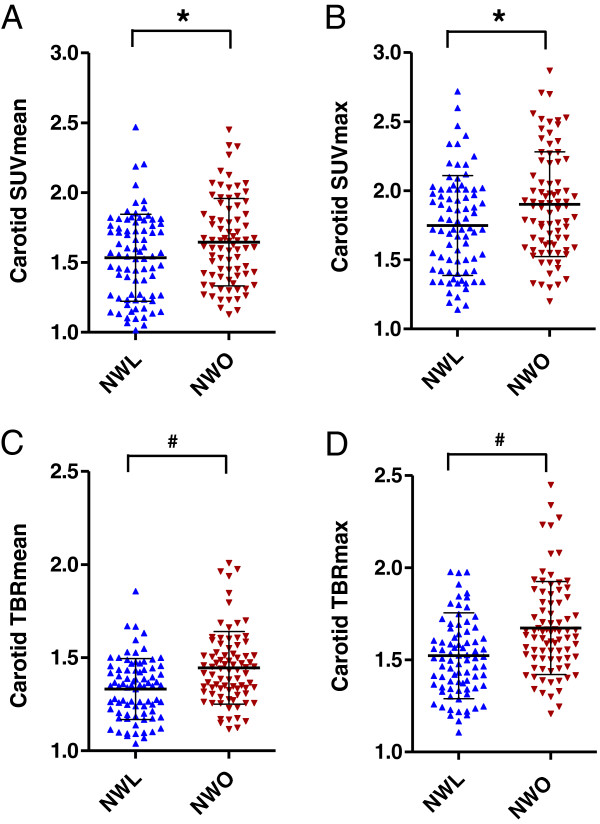
Scatter plot and comparison of the 18 F-FDG-PET/CT results between NWL and NWO subjects. A scatter plot of the 18 F-FDG-PET/CT results was drawn, and a comparison between the NWL and NWO subjects was performed. (A) Carotid mean SUV, (B) carotid maximum SUV, (C) carotid mean TBR, and (D) carotid maximum TBR. 18 F-FDG-PET/CT, 18 F-fludeoxyglucose positron emission tomography/computed tomography; SUV, standardized uptake value; TBR, target-to-background ratio; NWL, normal weight lean; NWO, normal weight obesity. Horizontal lines in the graph indicate means, whereas perpendicular lines denote the standard deviation. *p < 0.05 versus NWL. #p < 0.001 versus NWL.